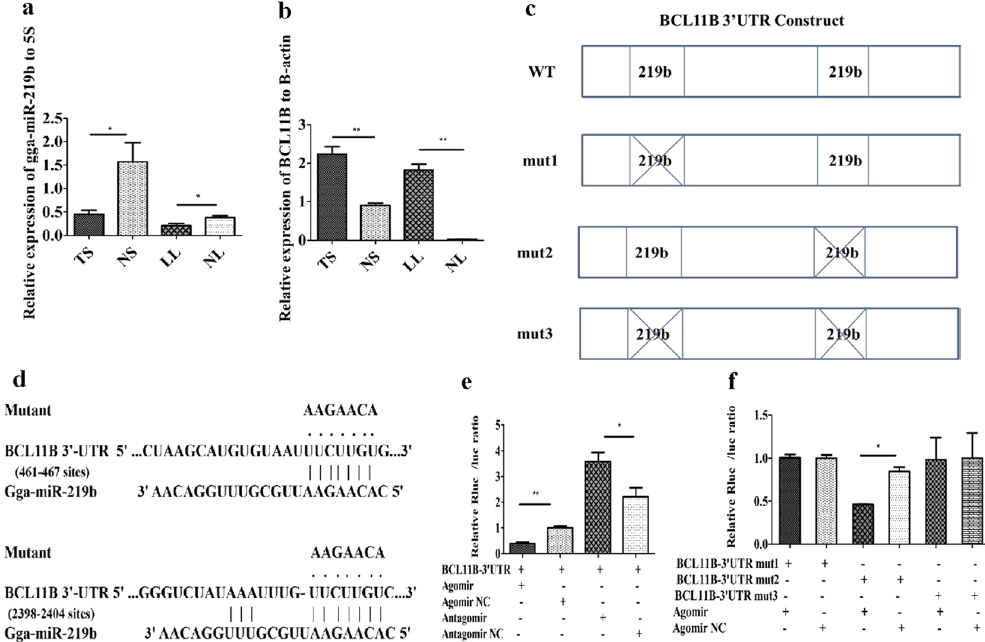
Figure 2. Validation of the predicted gga-miR-219b target gene. ( a,b ) Expression level of gga-miR-219b ( a ) and BCL11B ( b ) in non-tumorous spleen (NS), tumorous spleen (TS), non-tumorous liver (NL) and MD lymphoma from liver (LL) (n = 8). ( c ) Schematic diagram of gga-miR-219b candidate binding sites with the BCL11B 3 ′ - UTR as well as mutants interrupting the binding sequences predicted by miRDB and TargetScan. ( d ) Nucleotide sequences of the wild-type and mutated gga-miR-219b binding sites located in the 3 ′ -UTR of BCL11B. ( e,f ) Luciferase reporter assays in HEK293T cells transfected with reporter vectors containing either the wild-type ( e ) or mutated BCL11B-3 ′ UTR ( f ) (n = 5). Differences between two groups were analysed by Student’s t -test with the SAS system. The data are expressed as the mean ± S.E. * P < 0.05. ** P <